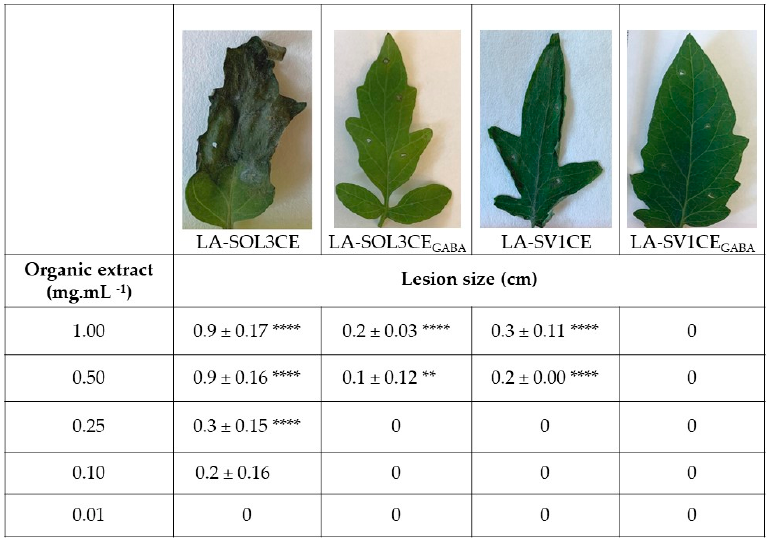
Figure 2. Phytotoxicity of crude extracts (1 mg mL − 1 ) of LA-SOL3 and LA-SV1 grown in absence (LA-SOL3CE and LA-SV1CE) and in the presence of γ -aminobutyric acid (GABA) at 10 mM (LA-SOL3CE GABA and LA-SV1CE GABA ). Statistical analysis was performed using two-way ANOVA, followed by a Tukey multiple comparison test. Asterisks correspond to data with statistical difference (**** p < 0.0001, ** p < 0.01, when compared to control.